Question: Write a caption explaining this figure to a reader.
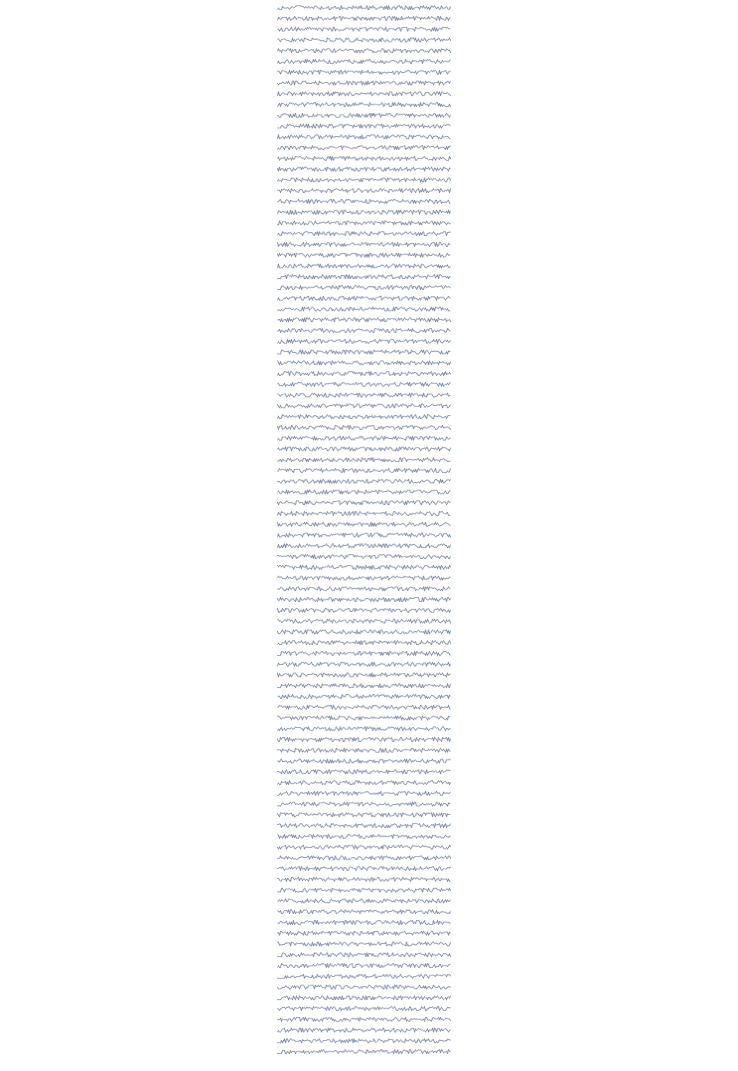
Answer: 100 trendlines for all NIST tests p-values on vectors of lengths between 3750 and 3849 with a pattern of all 1’s